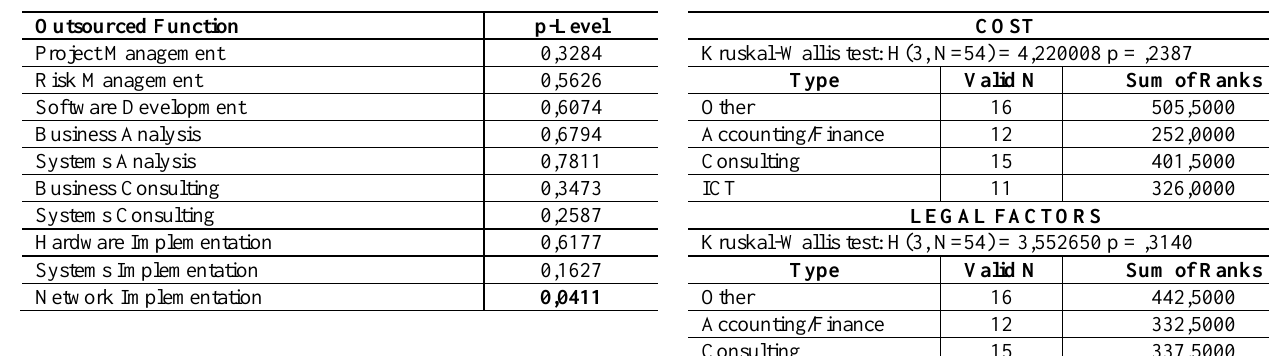
Table 8: Kruskal-Wallis p-values for type vs outsourced functions